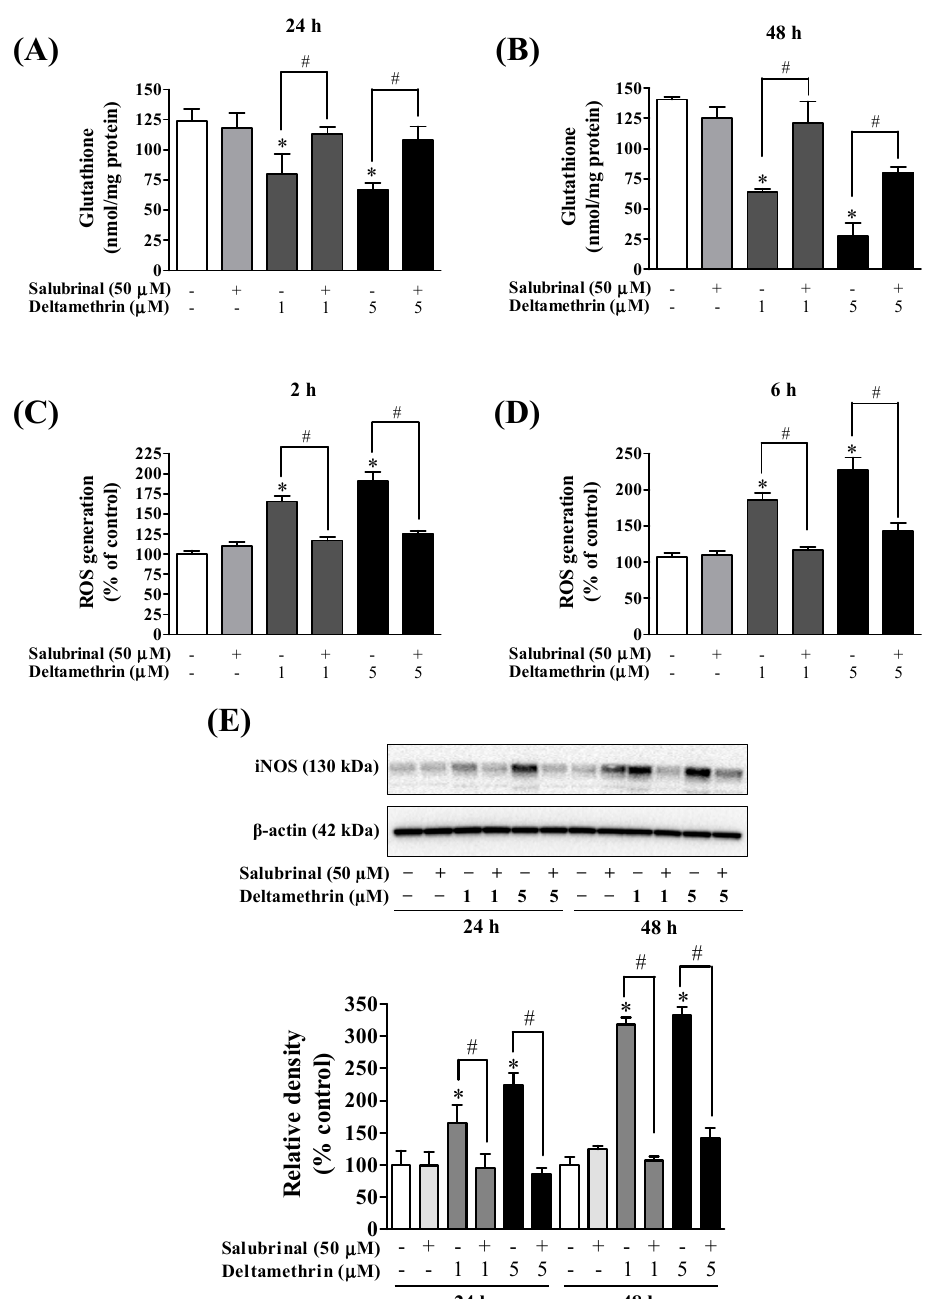
Figure 9. Salubrinal attenuated deltamethrin-induced decreased levels of GSH and increased levels of iNOS and ROS production. ( A , B ) levels of intracellular GSH, ( C , D ) generation of ROS, ( E ) protein levels of iNOS in MMCs cells. The protein bands were quantified by densitometry and the results reported as relative band densities. The values represent mean ± SEM from three independent experiments, each of which was performed in triplicate. An asterisk denotes significant difference from the control group, and a hashtag denotes significant differences between deltamethrin and deltamethrin + salubrinal ( p <